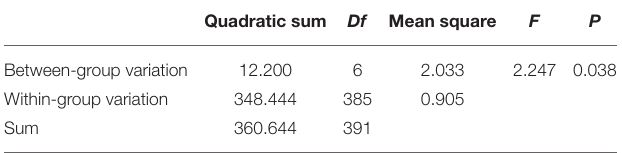
TABLE 7 | Correlation analysis results.